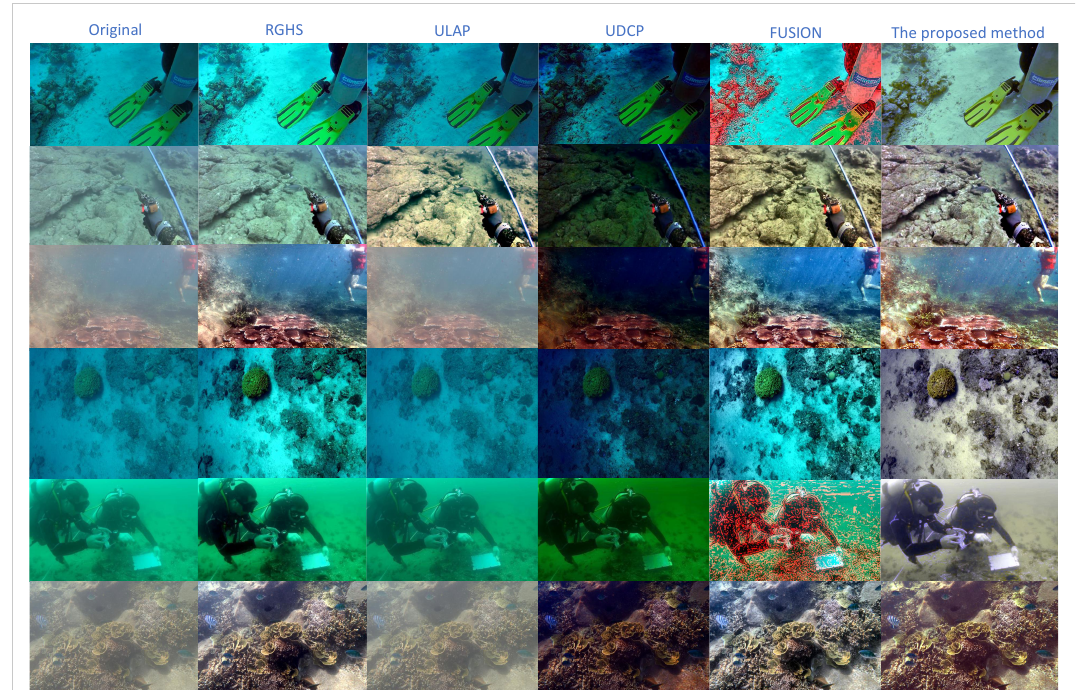
Figure 3. Visual comparison of the enhanced outputs produced by other SOTA underwater image enhancement methods and the proposed method. Original images are from the UIEB test dataset.